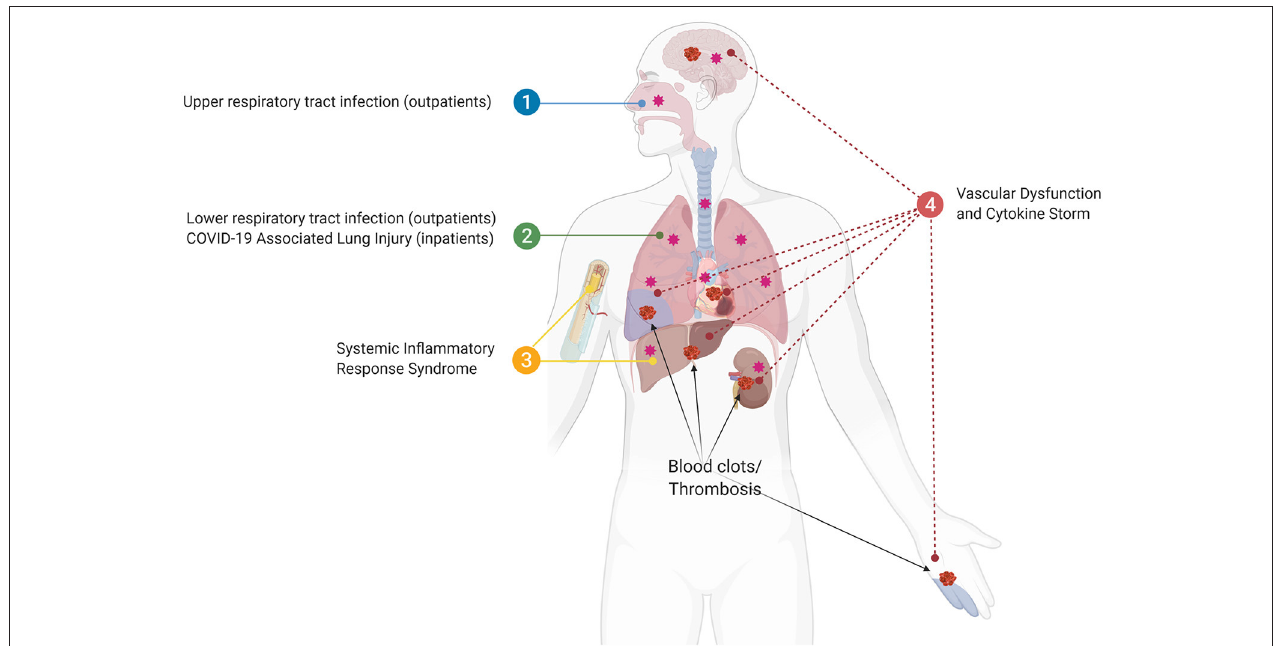
FIGURE 1 | The four phases of SARS-CoV2 infection. (1) Upper and lower respiratory tract infection (outpatients); (2) COVID-19 associated lung injury (CALI), in which some patients will be hospitalized (inpatients); (3) Systemic inflammatory response syndrome (SIRS), in which bone marrow and liver acute phase response accumulate pro-thrombotic factors resulting in blood clots/thrombosis; (4) The sustained loop between lung and systemic inflammation results in multi-organ vascular dysfunction and cytokine storm